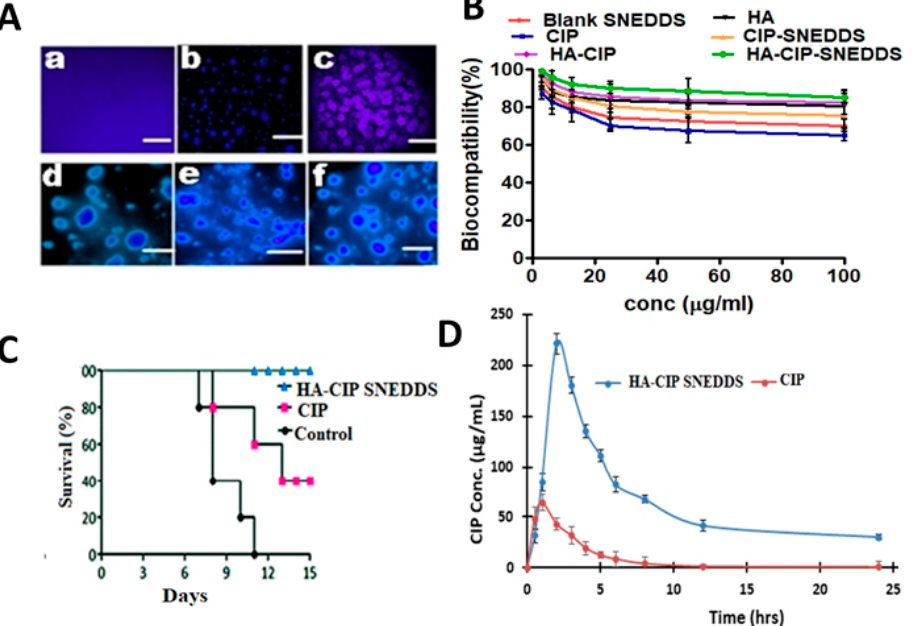
Figure 8. ( A ) FITC tagged step wise increase in florescence from Blank-PBS ( a ), Blank SNEDDS ( b ), CIP-SNEDDS ( c ), HA ( d ), HA-SNEDDS ( e ), and HA-CIP-SNEDDS ( f )*Scale bars: 50 µm), ( B ) Biocompatibility assay, ( C ) In-vivo survival assay of SNEDDS, ( D ) In vivo pharmacokinetics. Results of all experiments are listed as mean ± S.D.